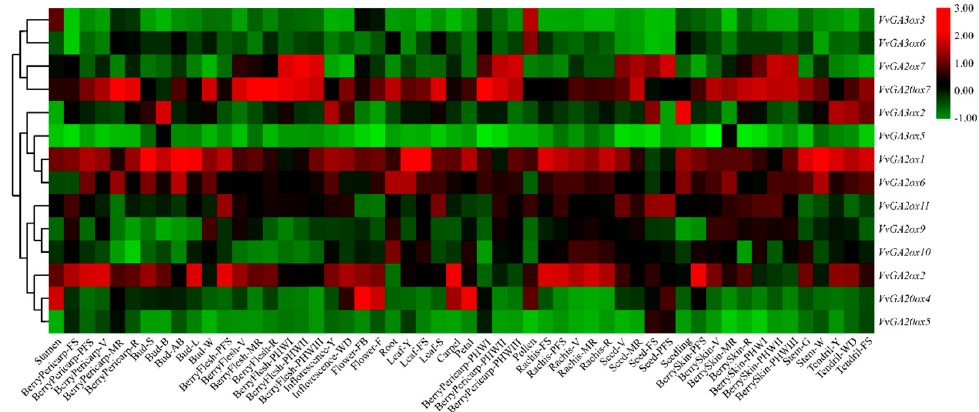
Figure 6. Hierarchical clustering of the expression profiles of 14 VvGAoxs genes at different organizations experiments in grape. Heatmap experiments were performed with GeneChip microarrays, which were from Grape eFP Browser in grape. Red or green shading represented the upregulated or downregulated expression level, respectively. The scale denoted the relative expression level. Note: Stamen, pool of stamens from undisclosed flowers at 10% and 50% open flowers; BerryPericarp-FS, berry pericarp fruit set; BerryPericarp-PFS, berry pericarp post-fruit set; BerryPericarp-V, berry pericarp véraison; BerryPericarp-MR, berry pericarp mid-ripening; BerryPericarp-R, berry pericarp ripening; Bud-S, bud swell; Bud-B, bud burst (green tip); Bud-AB, bud after-burst (rosette of leaf tips visible); Bud-L,